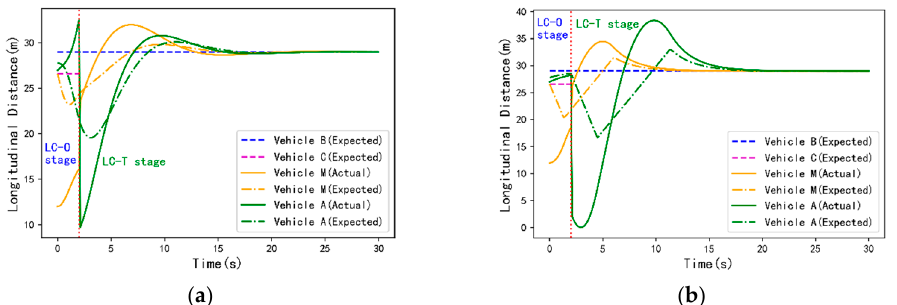
Figure 12. The longitudinal speeds of vehicles B, M and A of the two control strategies in scenario 2. ( a ) The proposed CLC control strategy, ( b ) CACC_Sine control strategy.